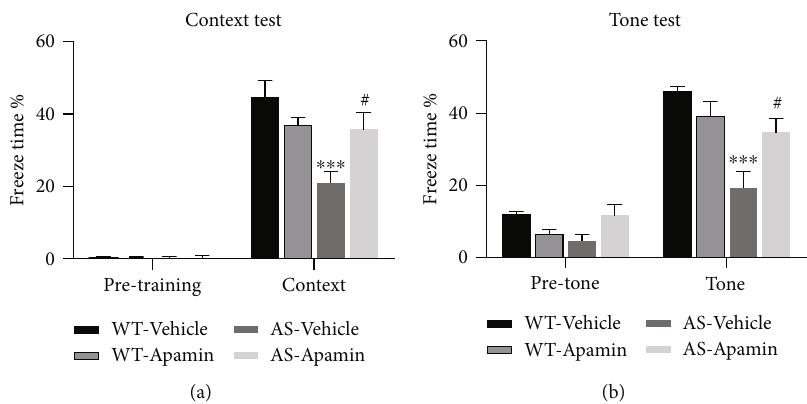
Figure 4: E ff ects of apamin treatment on fear conditioning in female WT and AS mice. WT and AS mice were treated with apamin (0.4 mg/ kg) 30min before training for fear-conditioning, as described in the Methods. Results are expressed as percent (%) time mice exhibited freezing behavior. (a) % freezing time for di ff erent experimental groups in context memory ( means ± SEM of 6-8 mice; ∗∗∗ P < 0 : 001 , as compared to WT-Vehicle mice; # P < 0 : 05 , as compared to AS-Vehicle mice (two-way ANOVA followed by the Tukey test; for genotype, F ð 1, 23 Þ = 10 : 29 , for treatment, F ð 1, 23 Þ = 0 : 8259 , for interaction, F ð 1, 23 Þ = 8 : 708 ). (b) % freezing time for di ff erent experimental groups in tone memory ( means ± SEM of 6-8 mice; ∗∗∗ P < 0 : 001 , as compared to WT-Vehicle mice; # P < 0 : 05 , as compared to AS- Vehicle mice (two-way ANOVA followed by the Tukey test; for genotype, F ð 1, 23 Þ = 16 : 17 , for treatment, F ð 1, 23 Þ = 1 : 229 , for interaction, F ð 1, 23 Þ = 8 : 343